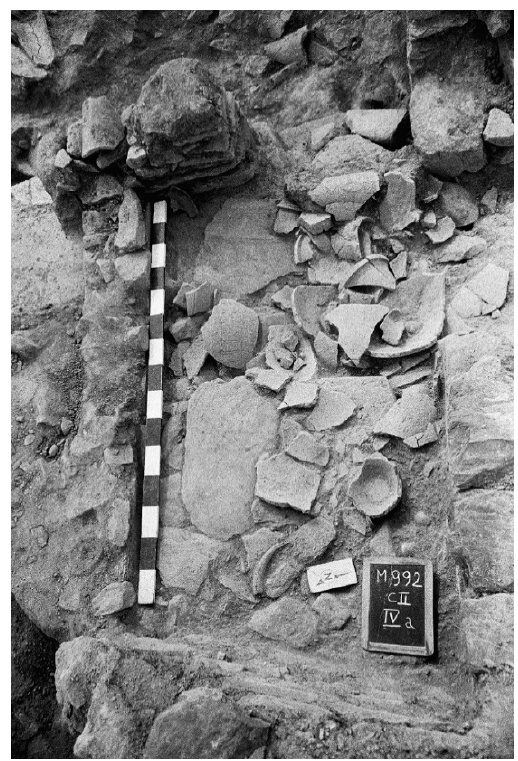
Figure 11. Mértola—house n. 2 (kitchen—exterior compartment). Photo took by author.